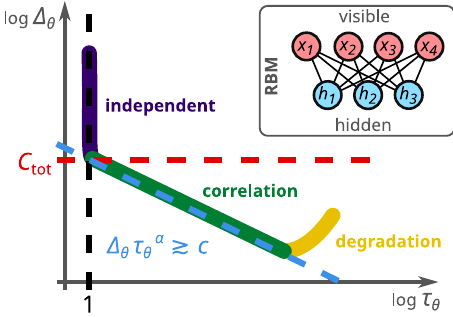
Fig. 1 | Schematic illustration of the three learning regimes. These learning stages of Restricted Boltzmann Machines (RBMs) are characterized by the rela- tionshipbetweenthemodel'sdivergence Δ θ fromthetargetdistribution(accuracy, cf. Eq. (3)) and its integrated autocorrelation time τ θ (ef fi ciency, cf. Eq. (6)): inde- pendent learning with improved accuracy at no ef fi ciency loss, correlation learing with a power-law tradeoff relation between accuracy and ef fi ciency, and the degragation regime with steady or diminishing accuracy and loss of ef fi ciency. Inset: Schematic illustration of the RBM structure comprised of visible and hidden units.